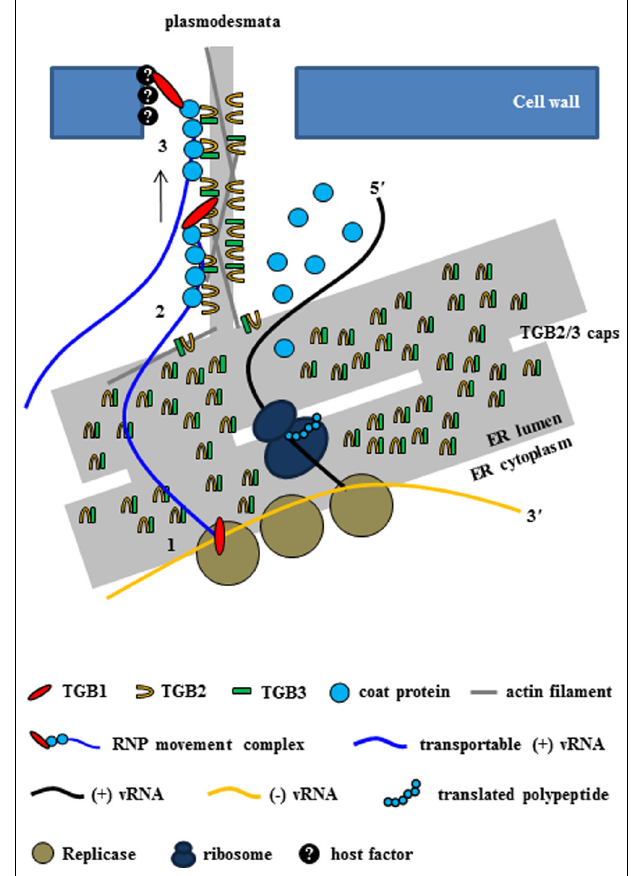
FIGURE 3 | Intercellular transport of potexvirus vRNA to PD at the late stage of viral infection. The PD-transportable potexvirus vRNA (blue line) is released from the intermediate double-stranded RNA form byTGB1 protein acting as an RNA helicase (1).The PD-transportable potexvirus vRNA is partially or fully encapsidated by CP subunits, and thenTGB1 protein associates with the 5 (cid:2) end of the partially or fully CP-coated vRNA for the formation of the RNP movement complex at PD “cap” structures that consist ofTGB2,TGB3 proteins, andVRC at the ER adjacent to the PD orifice (2).Then, theTGB1-driven RNP movement complex directs the nascent virions into the PD pore (3,Tilsner etal.,